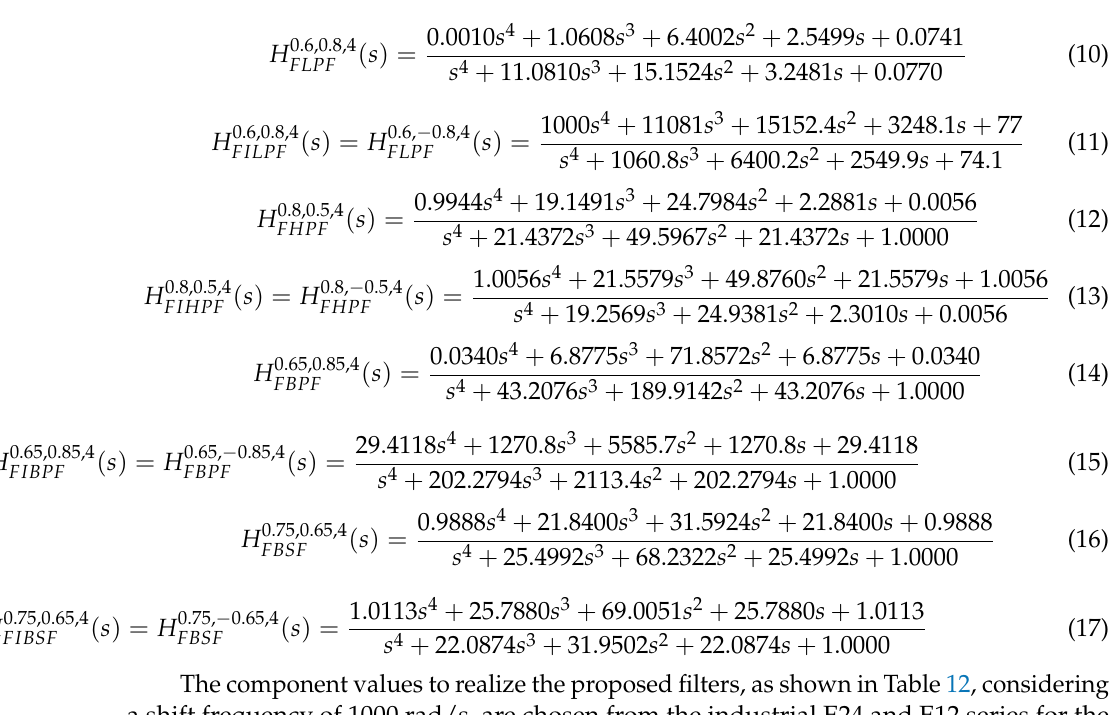
resistors and capacitors, respectively. The actual values of R 1 and R 5 for the FLPF